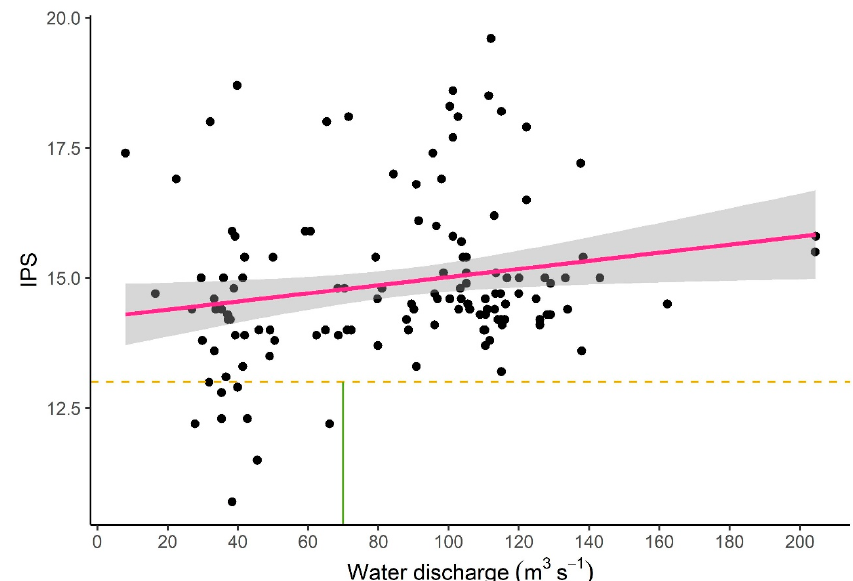
Figure 12. Changes of the IPS index values as a function of water discharge, based on the composition of diatom assemblages from both deployed and natural reed at c5 and c6 sampling points of the Cikola tributary system with a linear trend line fitted to the points. Dashed orange line represents good/moderate boundary of the index, green line indicates water discharge threshold above which the index always reached good value.